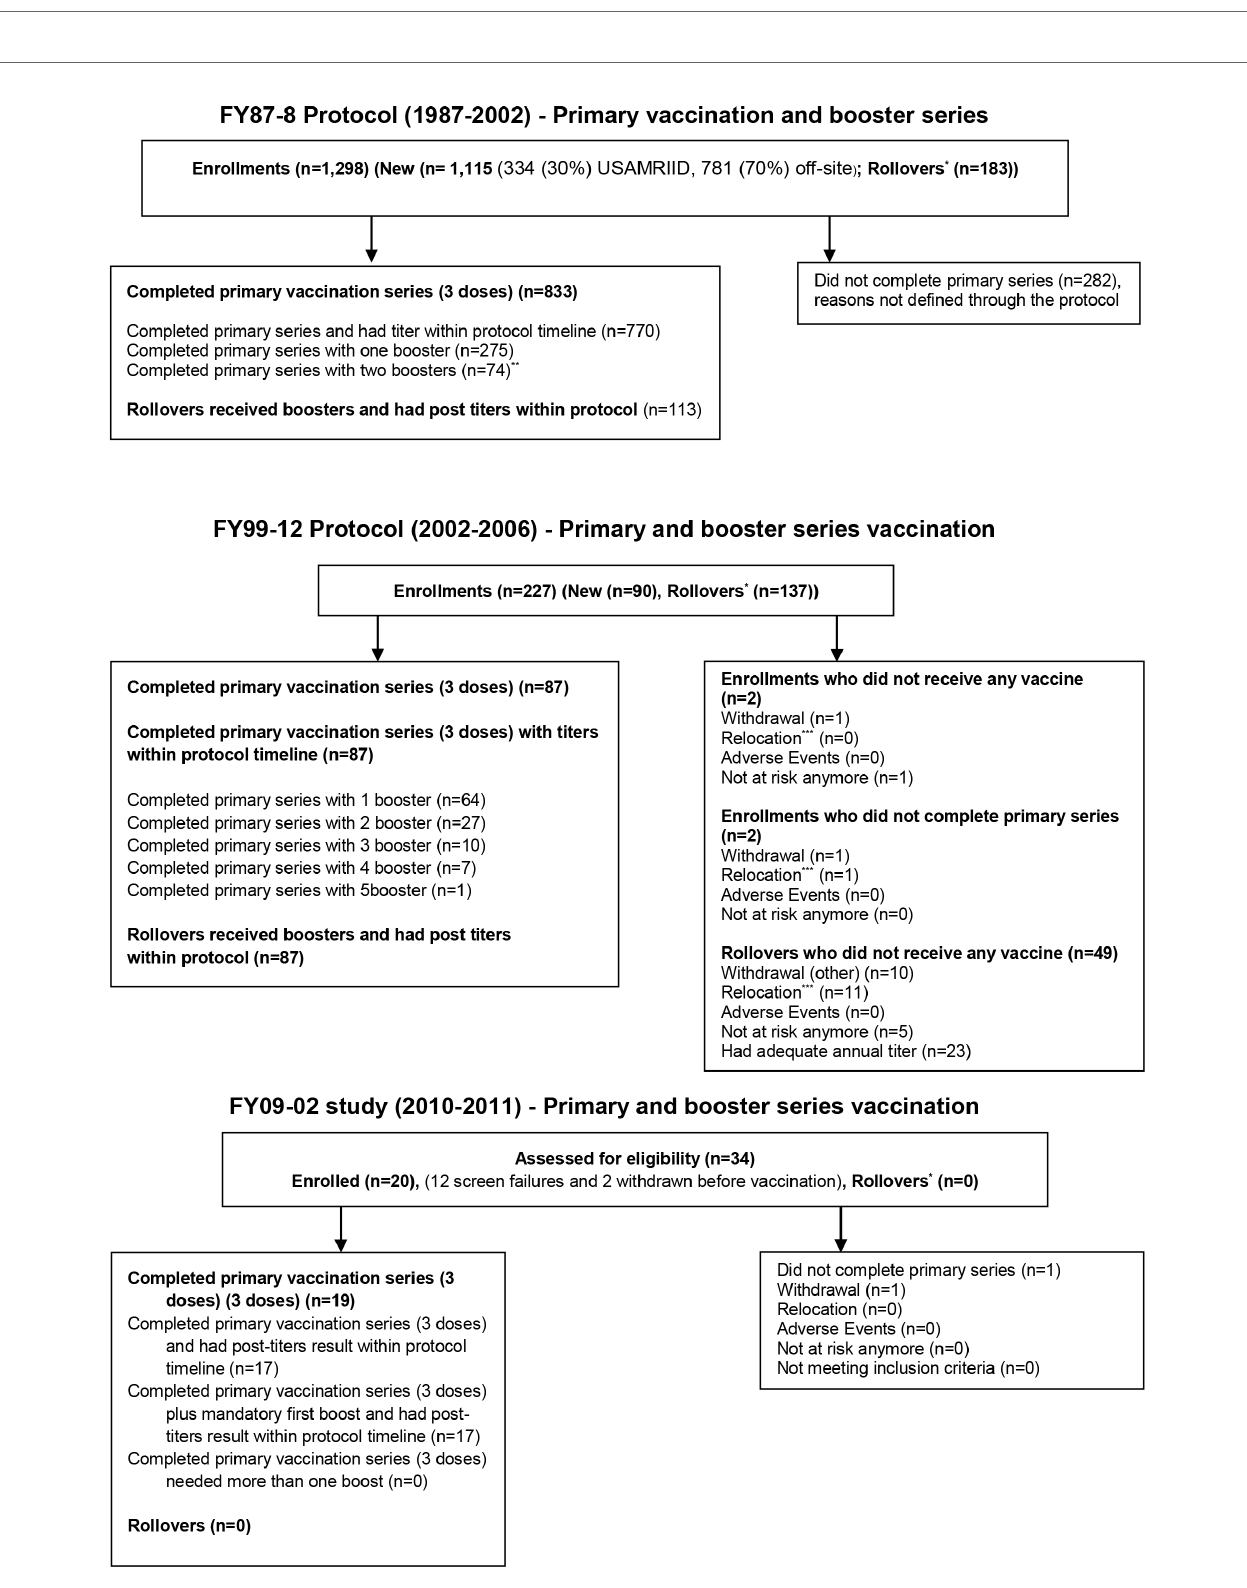
FIGURE 1 | CONSORT diagram of study enrollment. *Rollovers (subjects recruited from previous protocols); **No more than two boosters required within this protocol; ***Relocation (subjects moved due to new job).